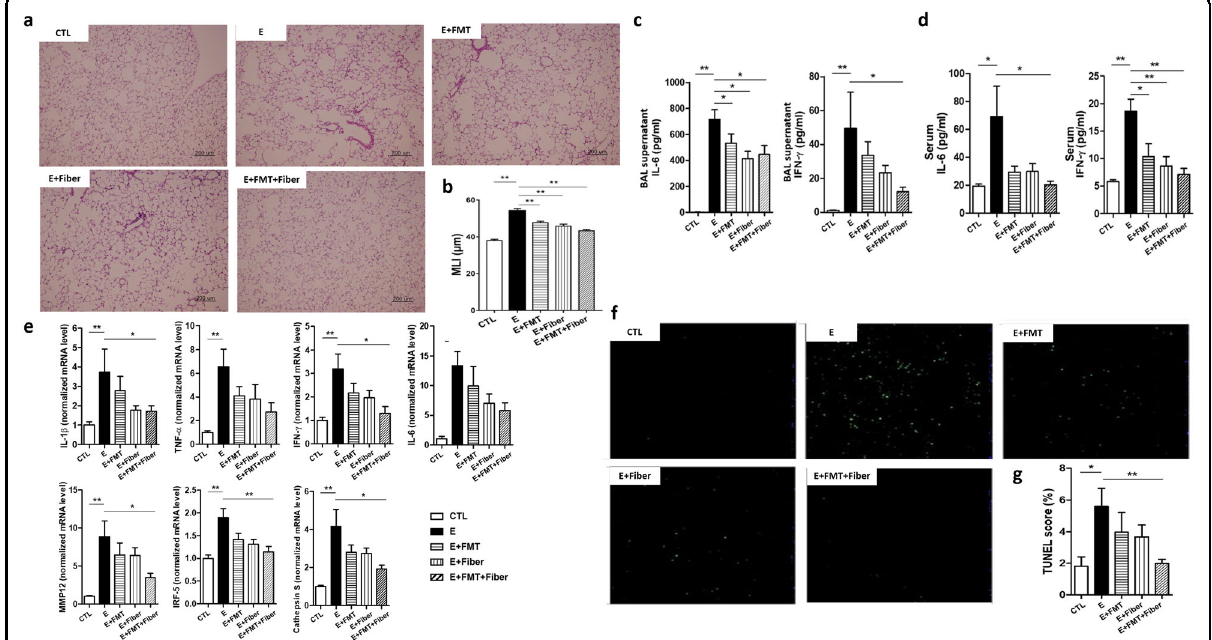
Fig. 3 The effect of FMT and dietary modi fi cation on emphysema (Experiment 3). a Representative H&E-stained lung tissues from mice in the control, emphysema, emphysema with FMT, emphysema with high- fi ber diet, and emphysema with both FMT and high- fi ber diet groups (magni fi cation: 100×). b The MLI of lung tissues from each group. c, d The levels of IL-6 and IFN- γ cytokines in the BALF ( c ) and serum ( d ) measured using ELISA. e The relative mRNA levels of IL-1 β , TNF- α , IFN- γ , IL-6, MMP-12, IRF-5, and Cathepsin S in the lung tissue. f Representative TUNEL images of lung tissue from mice in the control, emphysema, emphysema with FMT, emphysema with high- fi ber diet, and emphysema with both FMT and high- fi ber diet groups. g TUNEL score (%) of each group. TUNEL score (%) = TUNEL cells × 100/total cells ( n = 6 mice per group; n = 4 control mice for IFN- γ and IL-6 analysis in BALF and serum). Values are expressed as the mean ± SE. * P < 0.05 and ** P < 0.01. CTL control, E emphysema, FMT fecal microbial